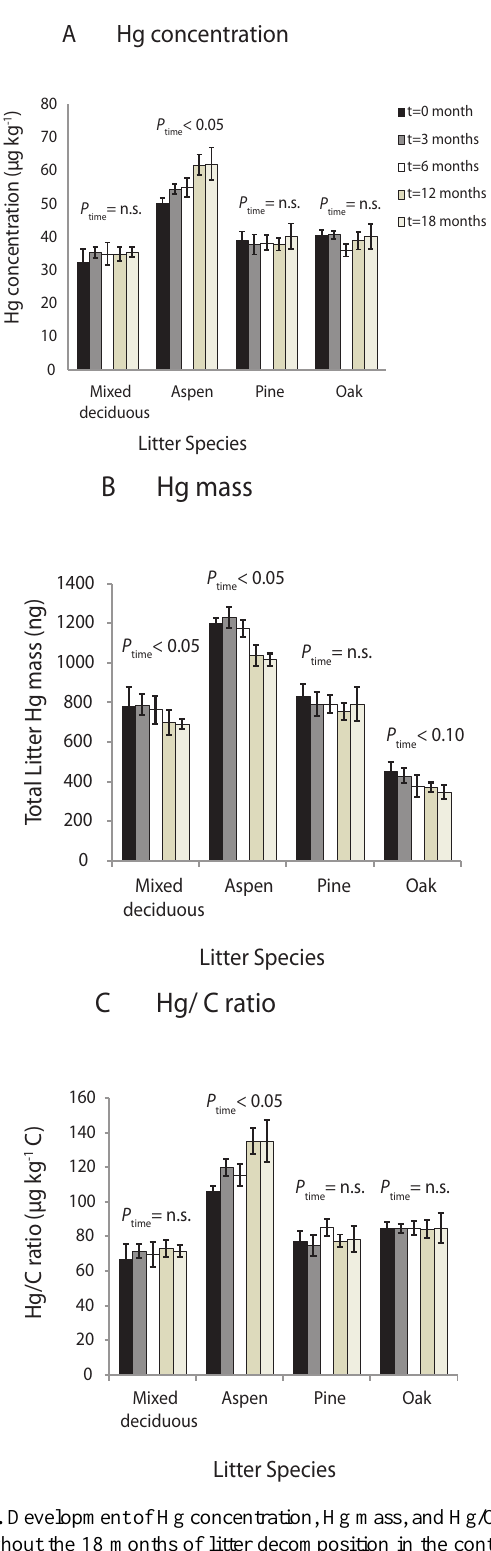
Fig. 2. Development of Hg concentration, Hg mass, and Hg/C ratio throughout the 18 months of litter decomposition in the controlled laboratory study. Bars represent means ± standard deviations of five replicate samples. P -values are effects of Time for individual species based on Bonferroni post-hoc analyses (Table